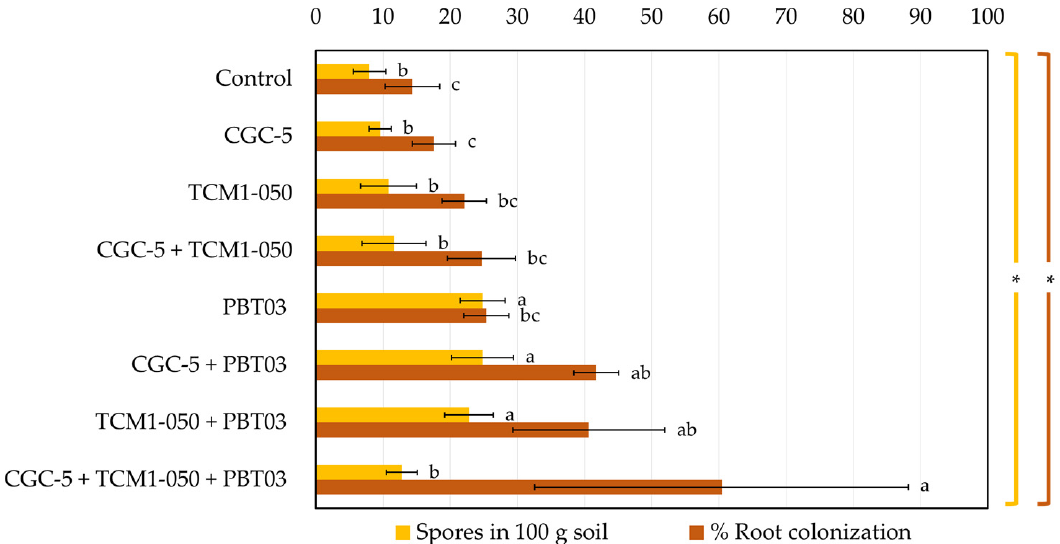
Figure 6. Spore counts and root colonization percentages of arbuscular mycorrhizal fungi. Different treatments were established, including a non-inoculated control and those inoculated with Agrobacterium sp. CGC-5, Kitasatospora sp. TCM1-050, Claroideoglomus sp. PBT03, or different consortia of these microbes. The experiments were done in five replicates. Small case letters refer to the statistical difference of means compared by one-way ANOVA at α 0.05. The statistical results comprise of arbuscular mycorrhizal spores in 100 g soil ( F (7, 32) = 20.75, p ≤ 0.0005) and root colonization percentages ( F (7, 32) = 9.71, p ≤ 0.0005). The asterisk remark indicates the statistical significance.